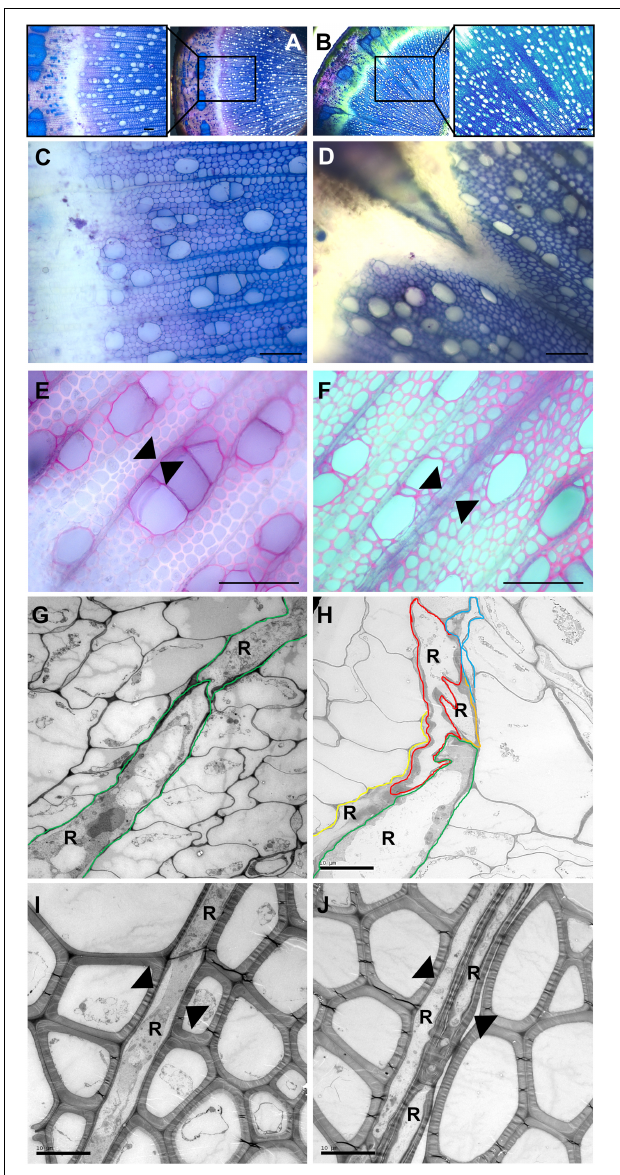
FIGURE 2 | Stem anatomy in wild type and transgenic POPACAULIS5 trees. Transverse sections were taken from the 35th internode from stems of wild type (A,C,E,G,I) and transgenic POPACAULIS5 lines B2 and B13 (B,D,F,H,J) stained with toluidine blue-O (A–D) and phloroglucinol (E,F) . Insets in (A,B) show increased magnification of stem tissues where disturbances were observed in secondary phloem, cambial zone and secondary xylem in both transgenic POPACAULIS5 lines but not in the WT trees. (G–J) Electron micrographs from wild type (G,I) and POPACAULIS5 stems (H,J) . Colored lines were painted in (G,H) to highlight individual cambial ray initial derivatives (R) in the cambial zone. Arrowheads in wild type indicate uniseriate rays whereas biseriate rays were present in the secondary xylem of the transgenic POPACAULIS5 trees. Scale bars: (A–F) 100 µ m, (G,H) 10 µ m.